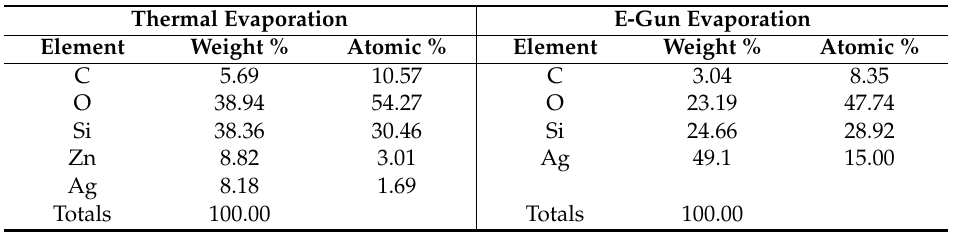
Table 1. EDS analysis of 30 nm thick silver films deposited by thermal and E-gun evaporation.